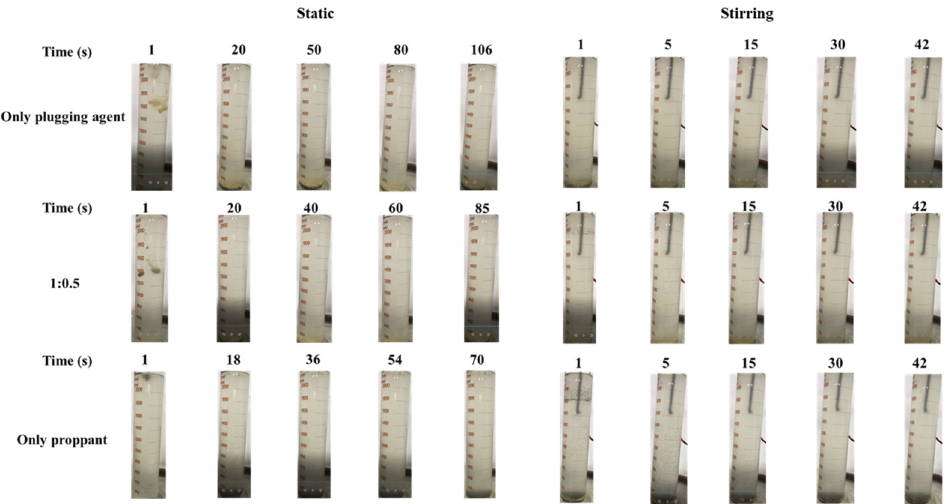
Figure 13. Settlement of the plugging agent and proppant (density = 1.15 g/cm 3 ) in the guanidine gum solution.